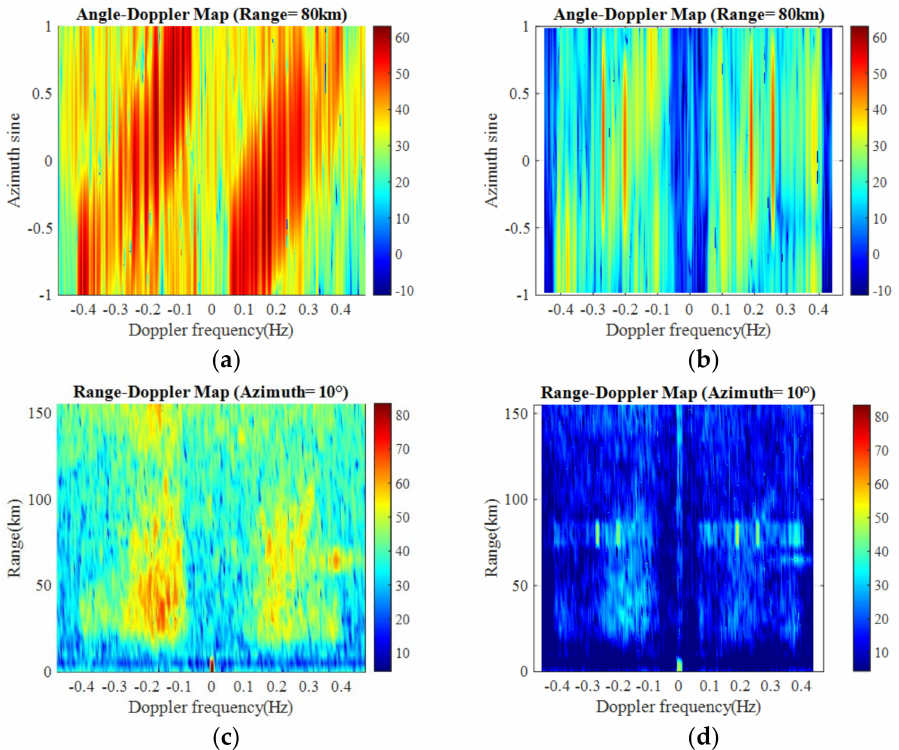
Figure 8. Angle-Doppler map and range-Doppler map before and after clutter suppression. ( a ) Angle- Doppler map before clutter suppression. ( b ) Angle-Doppler map after clutter suppression. ( c ) Range- Doppler map before clutter suppression. ( d ) Range-Doppler map after clutter